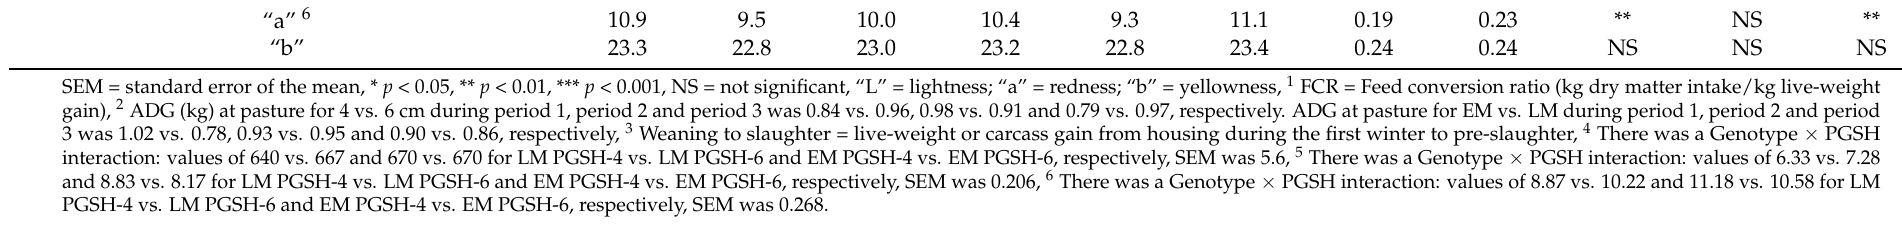
Table 6. The effect of genotype (G-early- (EM) or late-maturing (LM)), post-grazing sward height (PGSH-4 or 6 cm) and finishing diet (Diet-grass silage only (SO) or grass silage supplemented with 3.8 kg concentrates dry matter (SC)) on ultrasonic measurements of suckler-bred steers at turnout to pasture, housing for the finishing winter and pre-slaughter. Genotype p -Value 1 Ultrasonic Time Interval Measurement Rib fat